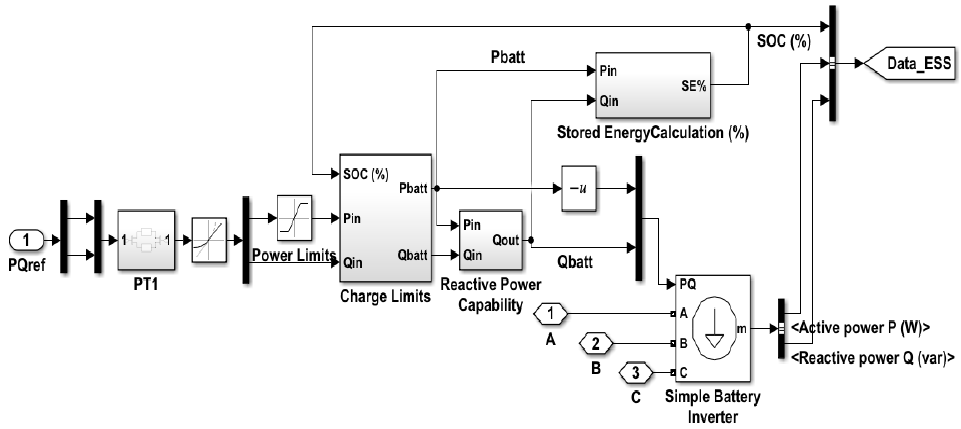
Figure 7. Model of ESS.